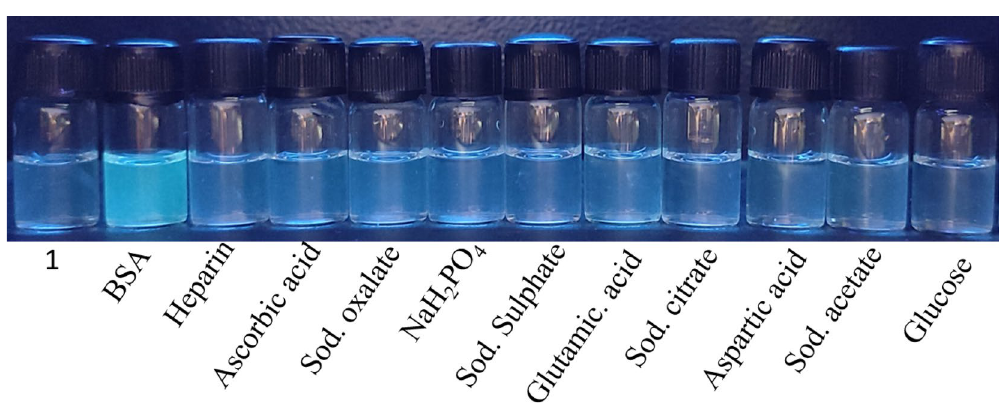
Figure 3. Picture of TPE-kana 1 in in distilled water with and without addition of BSA and other biological competitors under UV light 365